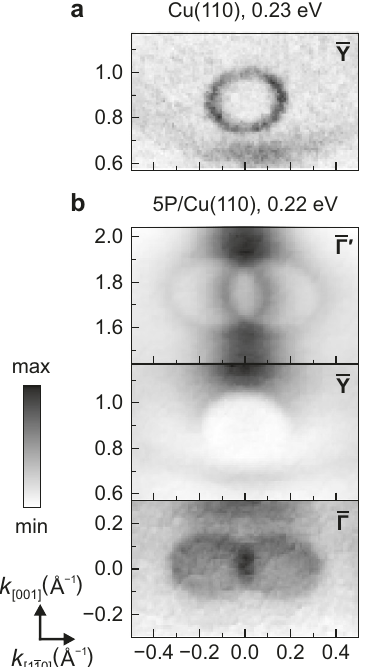
Fig. 3 | Zoomed momentum maps around high-symmetry points of Cu(110). a CleanCu(110)aroundY. b 5P/Cu(110)around Γ 0 ,Y,and Γ .Thedifferentsizesofthe depletionzonesatYandcloseto Γ 0 ontheonehandandtheinterfacestatecloseto Γ on the other hand can be observed